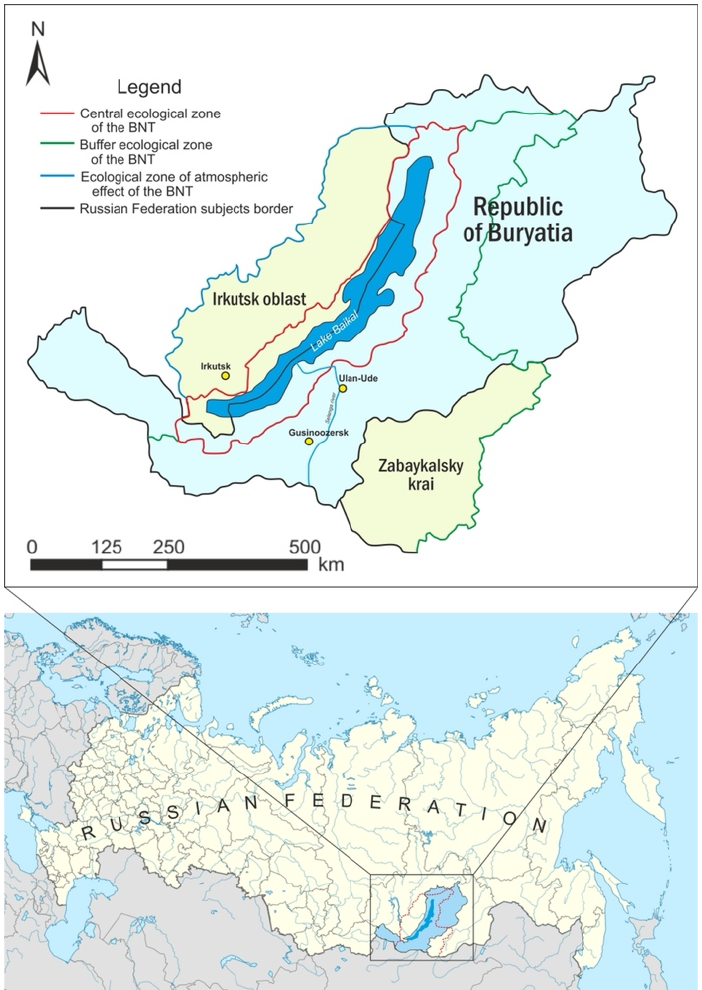
Figure 1. Baikal natural territory (BNT).